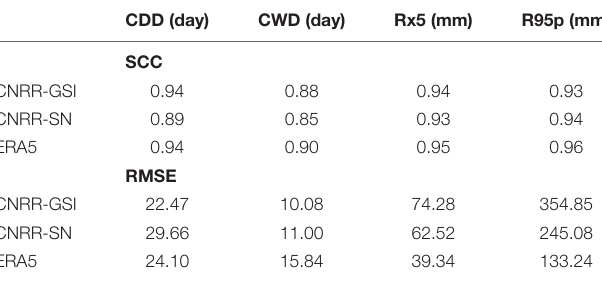
TABLE 4 | The SCCs and RMSEs of the extreme precipitation indices (CDD, CWD, Rx5 and R95p) between CNRRs, ERA5 and